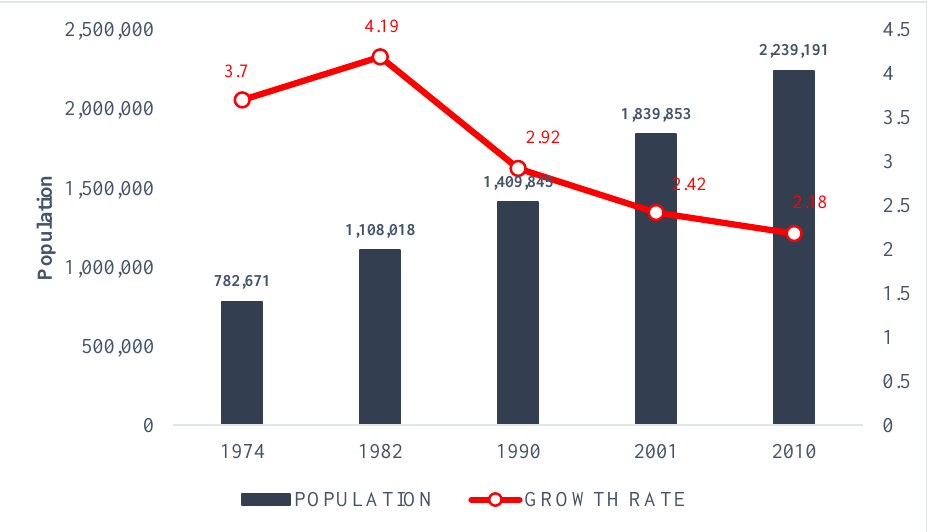
Figure 2. Quito population and growth rates (1974 – 2010).